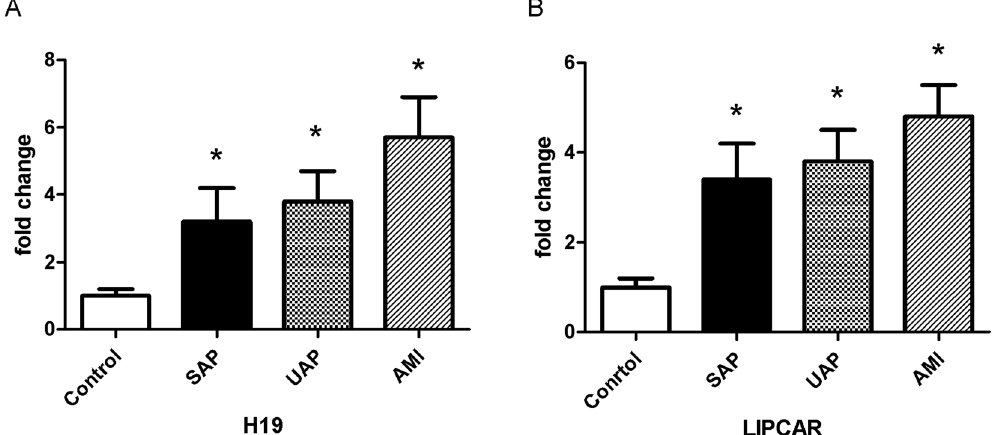
Figure 2. Plasma levels of H19 and LIPCAR in patients with SAP, UAP and AMI. Plasma levels of H19 ( A ) and LIPCAR ( B ) are increased in patients with SAP, UAP and AMI when compared with controls. However, no significant difference was observed among three subgroups. SAP, stable angina pectoris; UAP, unstable angina pectoris; AMI, acute myocardial infarction; * P <